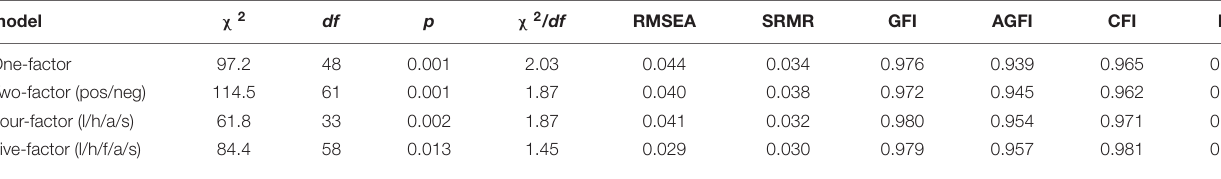
TABLE 4 | Confirmatory factor analysis for different models of the